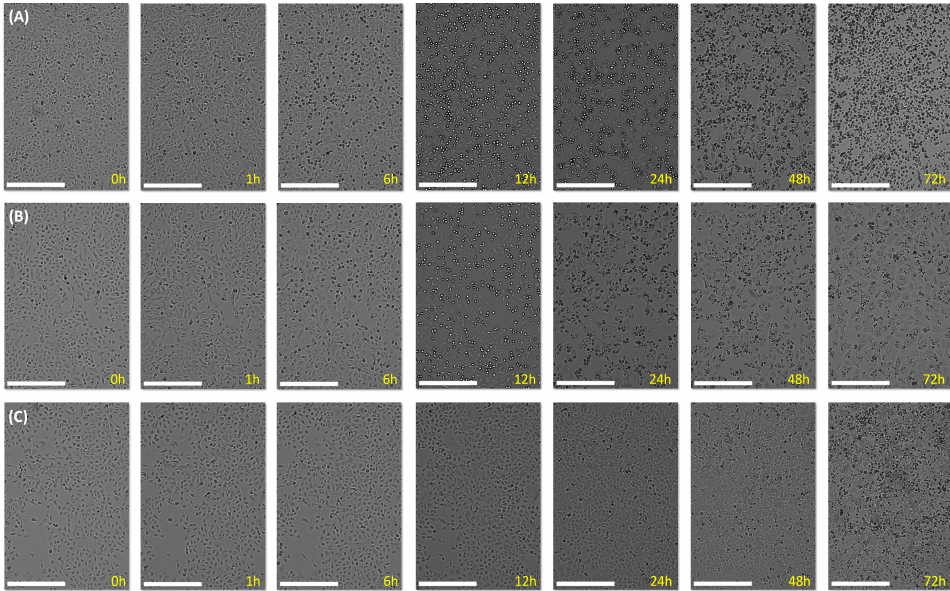
Figure 6. Cell morphology visualization with an X4 lens at 0, 1, 6, 12, 24, 48 and 72 h after exposure to compound 4l . Scale bar: 300 µm. ( A ) A549 cells treated with 1.1 µM of 4l . ( B ) A549 cells treated with 0.11 µM of 4l . ( C ) A549 cells treated with 0.02 µM of 4l .